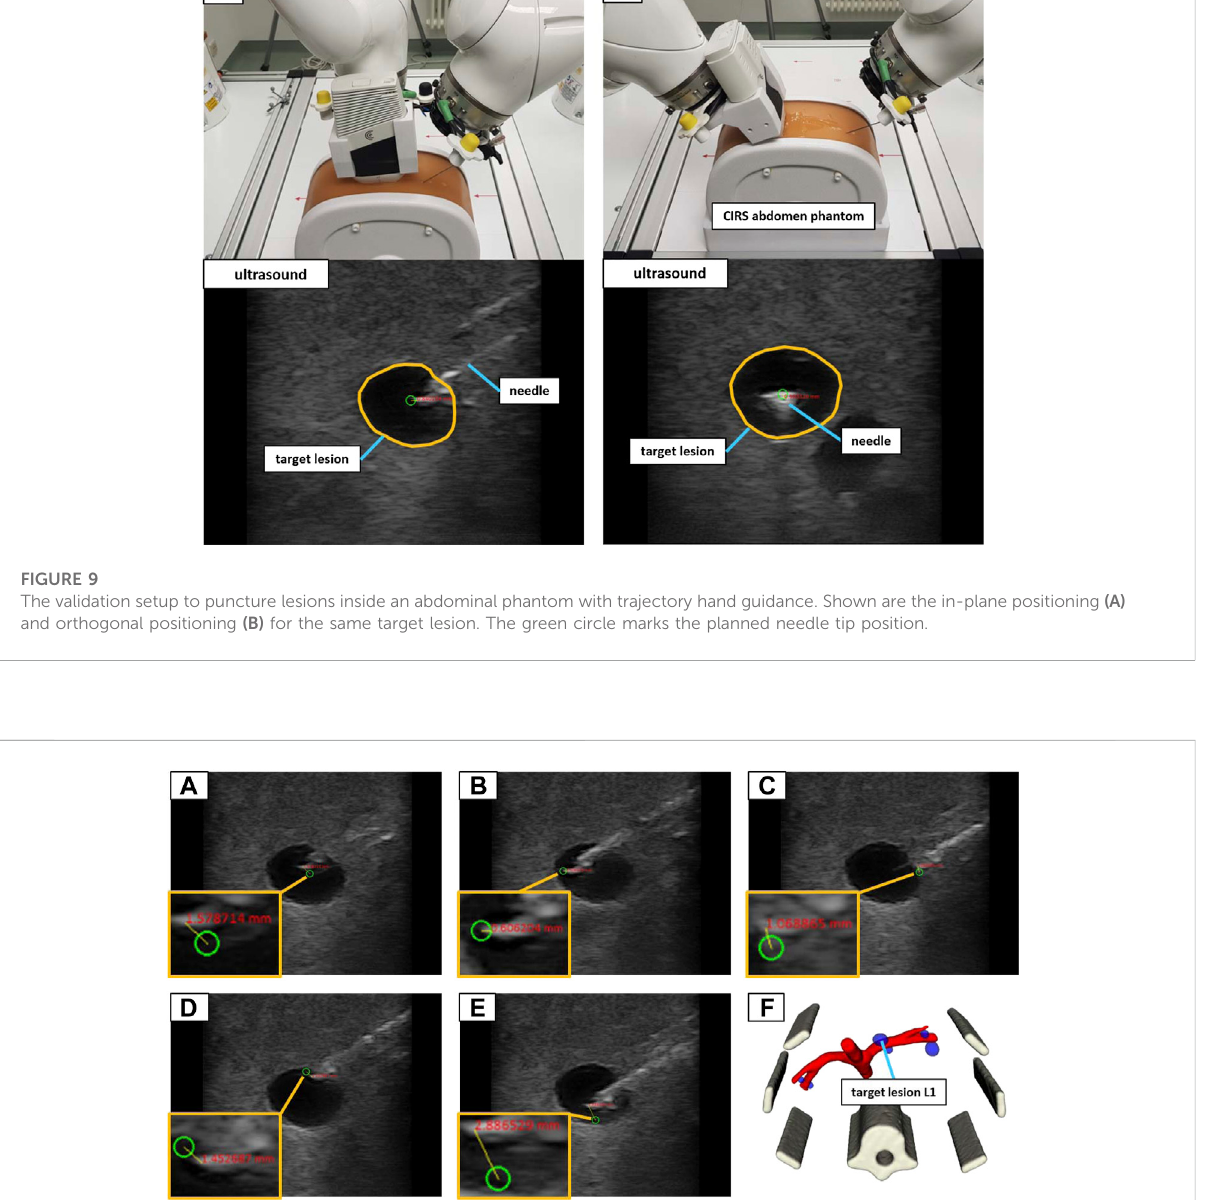
in Figure 10. The needle was advanced in hand guidance with the goal to minimize the distance of the needle tip to the planned target. The insertion depth was determined, relying on the visual feedback in the US image view.